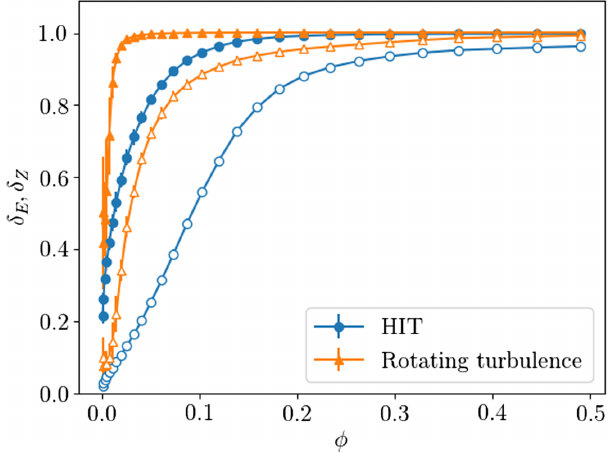
FIG. 12. Values of the velocity correlations δ E and the vorticity correlations δ Z (empty symbols) as a function of the volume fraction ϕ for homogeneous and isotropic turbulence (HIT) or under rotation. The HIT simulations have α t η ¼ 6 . 5 and τ =t η ¼ 1 . 5 , and the rotating turbulence ones have α t η ¼ 5 and τ =t η ¼ 2 . 0